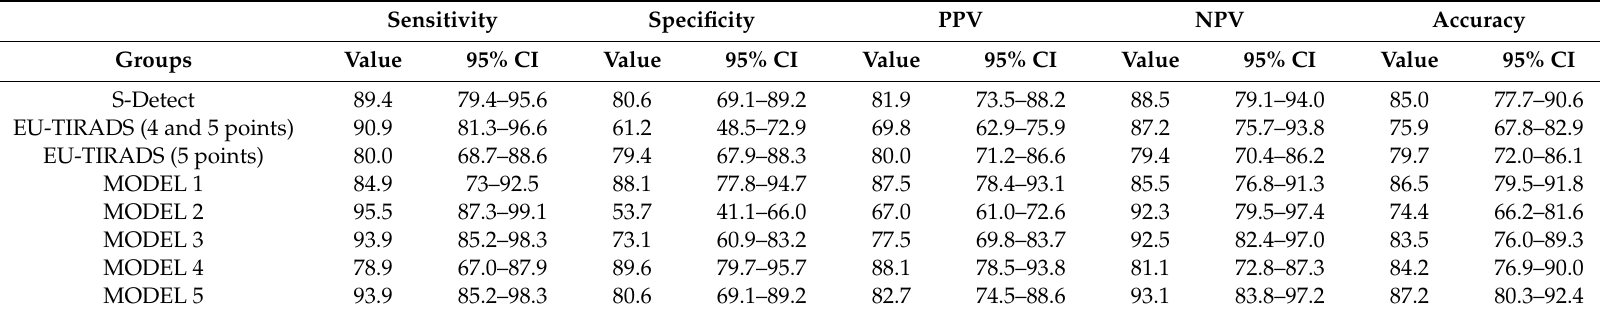
Table 1. Results for the assessment of thyroid lesions using S-Detect only, the European Thyroid Imaging Reporting and Data System (EU-TIRADS) scale (4 and 5 points), and the mixed MODELs 1 to